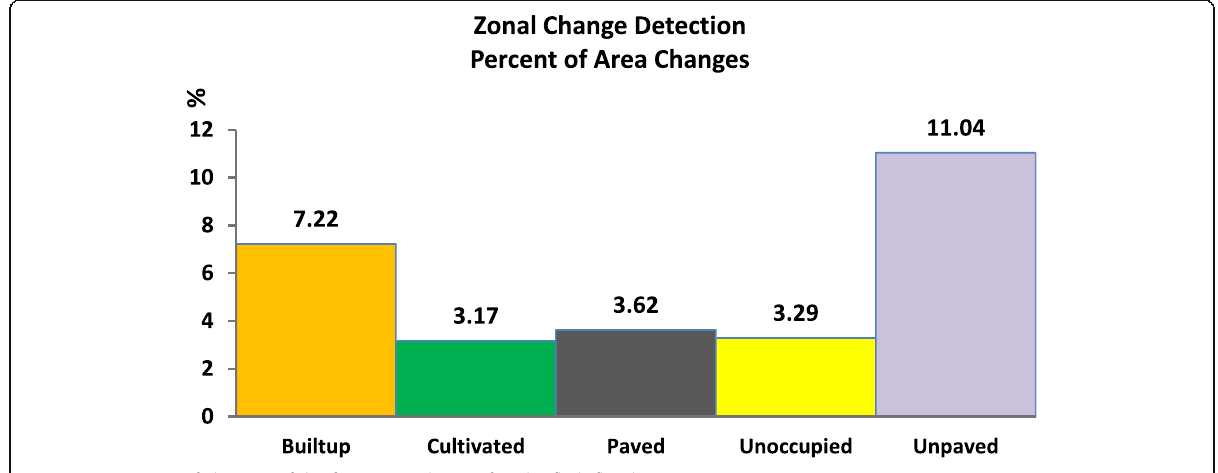
Fig. 5 Percentages of changes of the five LU/LC classes after the flash flood